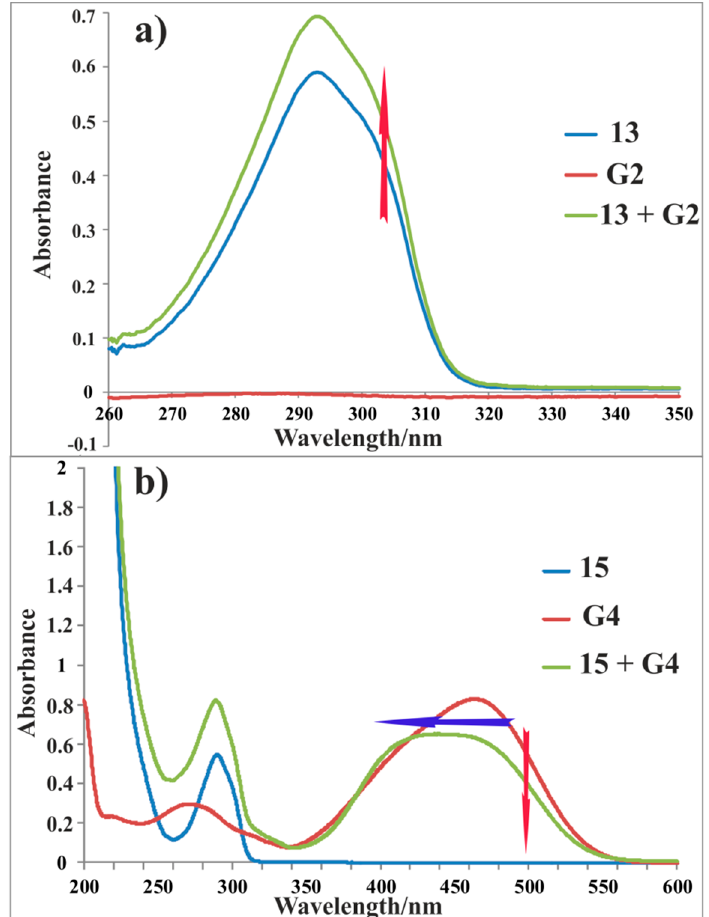
Figure 4. Electron absorption spectra: ( a ) pillar[5]arene 13 /guest G2 in the 10-fold excess of guest in DMSO (c macrocycle = 3 × 10 − 5 M, c guest = 3 × 10 − 4 M), red arrow means hyperchromic effect; ( b ) pillar[5]arene 15 /guest G4 in 1:1 ratio in water (c macrocycle = 3 × 10 − 5 M, c guest = 3 × 10 − 5 M), red arrow means hypochromic effect, and blue arrow means hypsochromic shift.